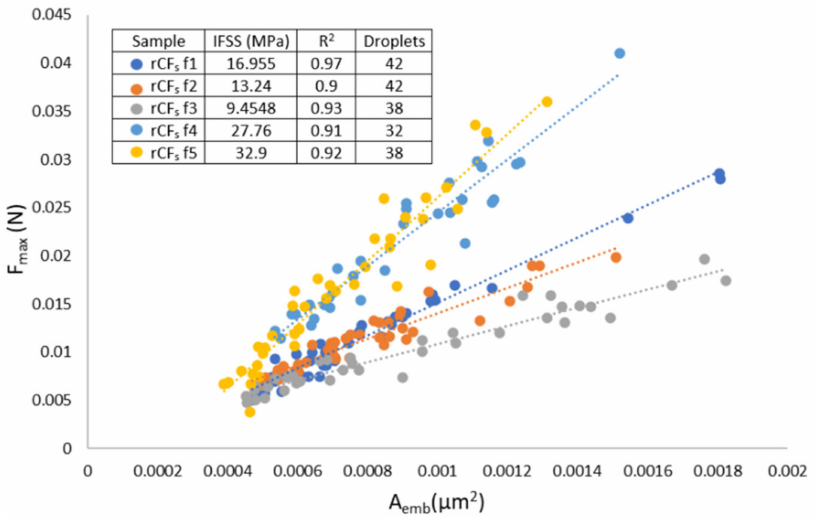
Figure 5. Individual data points for the rCF s fibers as a function of embedded area.